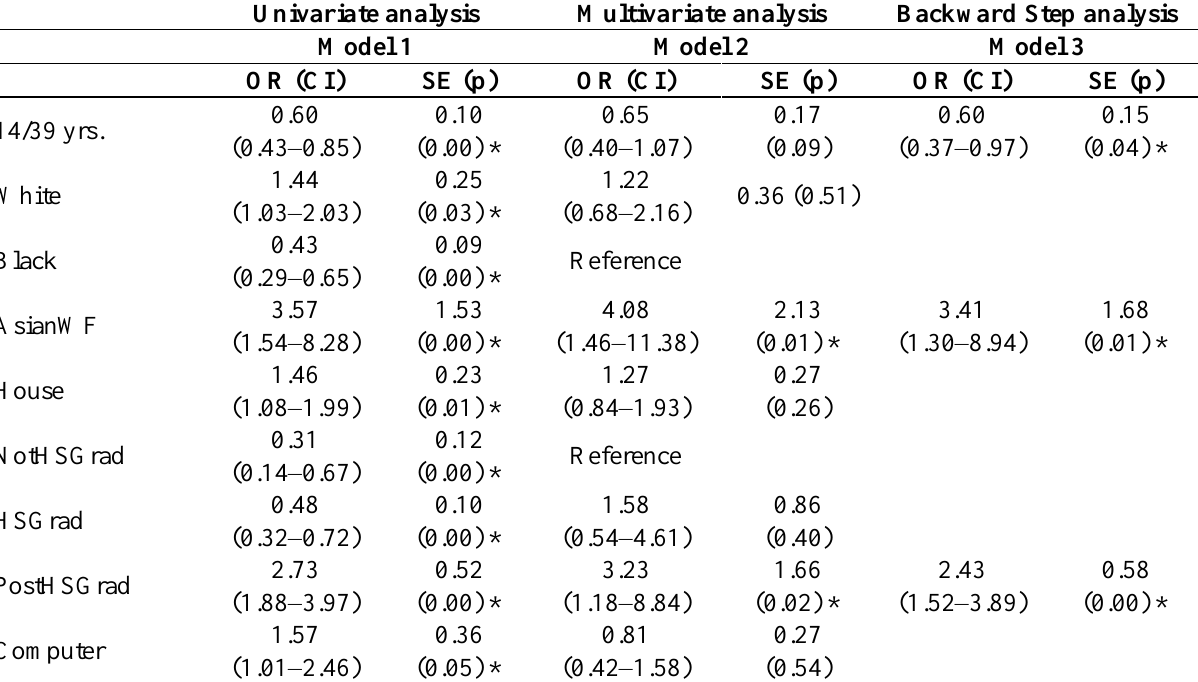
Table 7. Logistic models predicting charitable giving to international